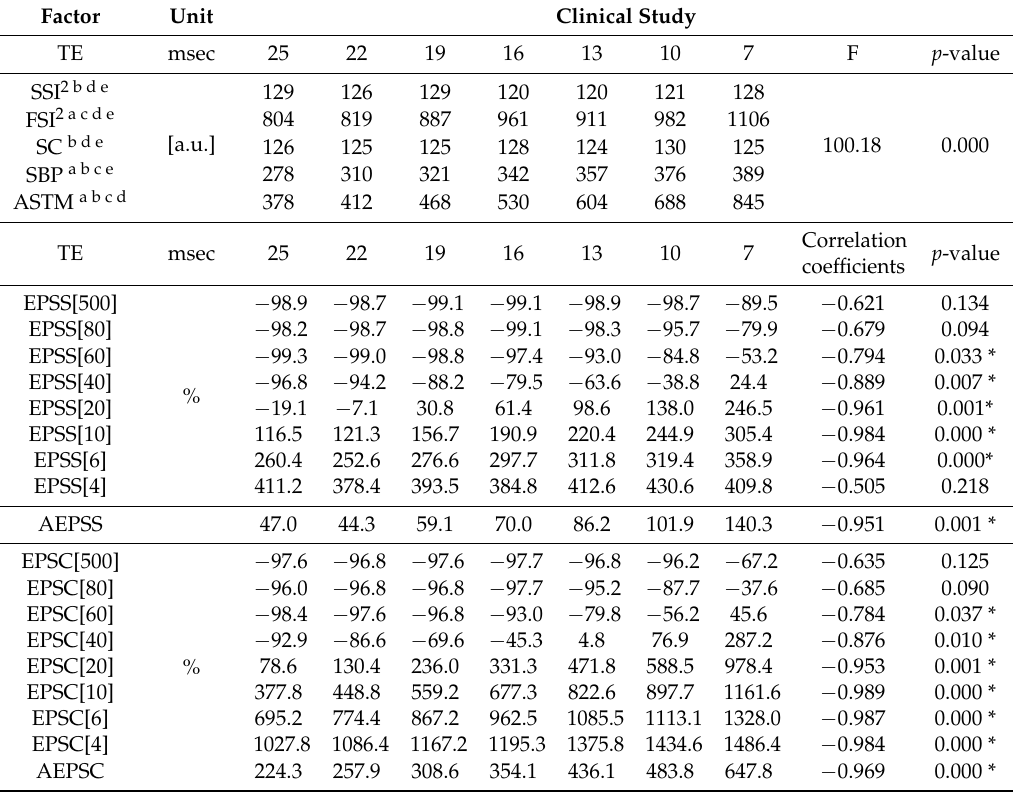
Table 4. Quantitative data for the different evaluation criteria in the clinical